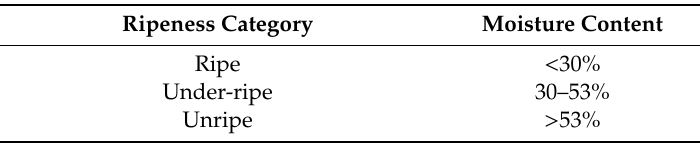
Table 1. Oil palm fruit ripeness based on moisture content.